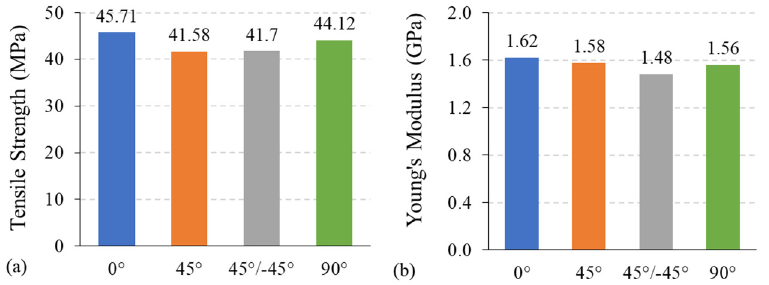
Figure 16. PEEK ( a ) strength and ( b ) Young’s modulus sensitivity to various raster angles (in de ‐